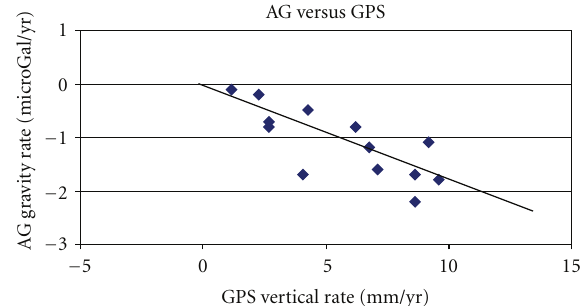
Figure 2: Linear regression between the gravity rate and the vertical uplift derived from permanent GPS in